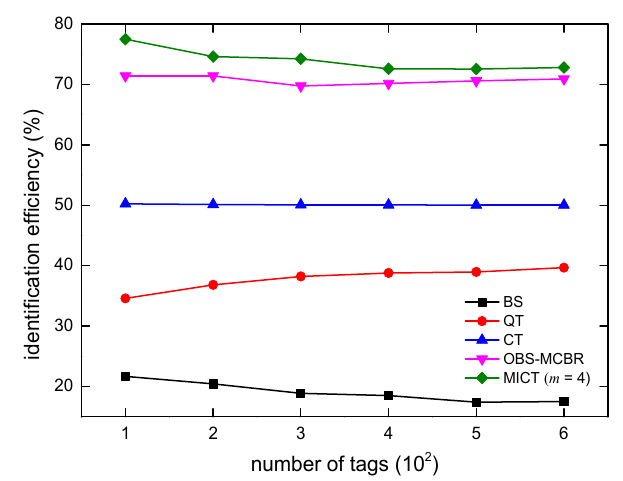
Figure 12. Comparison of the identification efficiency.